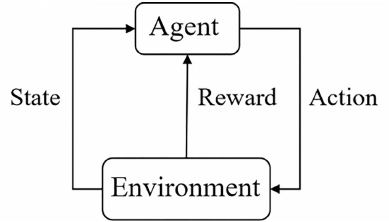
Figure 2. Basic principles of reinforcement